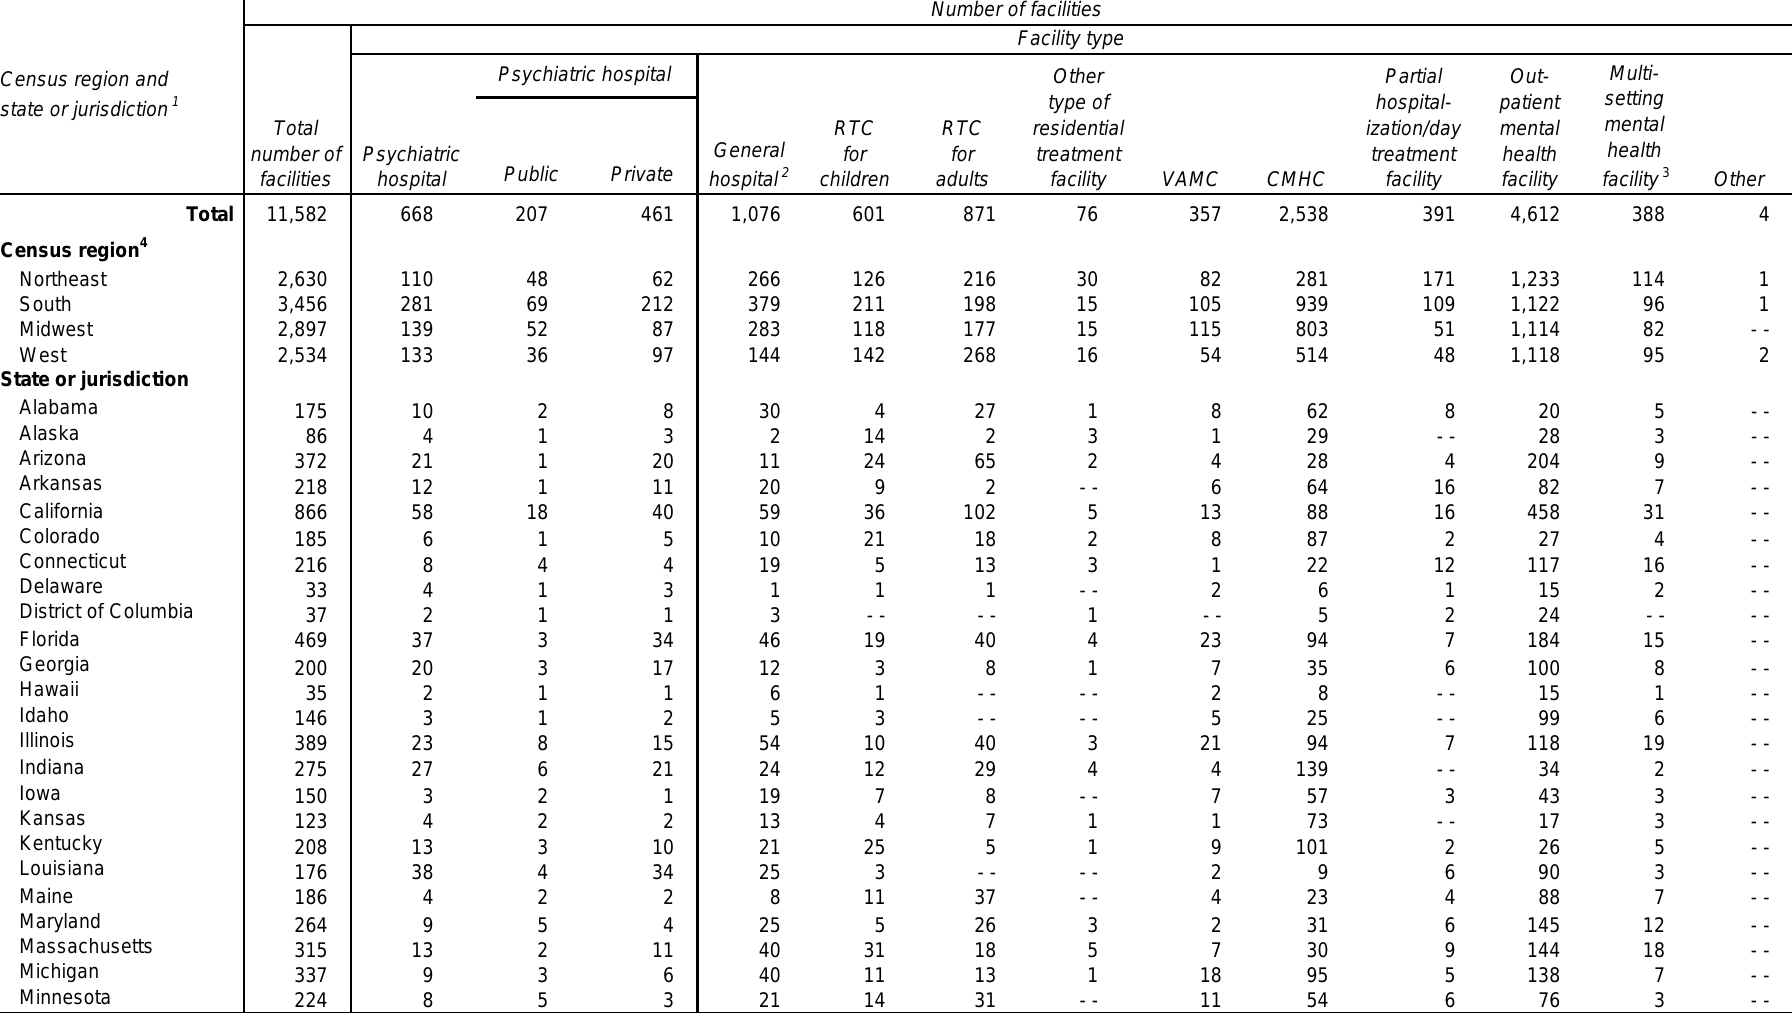
Table 3.1a. Mental health treatment facilities, by facility type, Census region, and state or jurisdiction: Number,